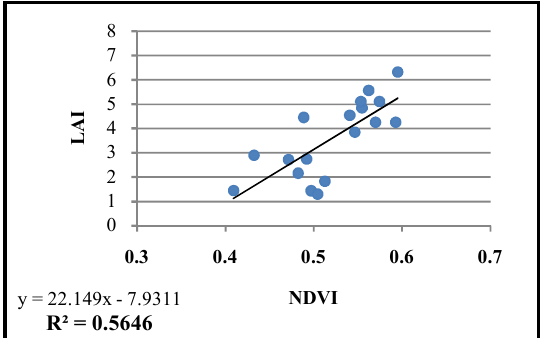
Figure 4. NDVI and LAI